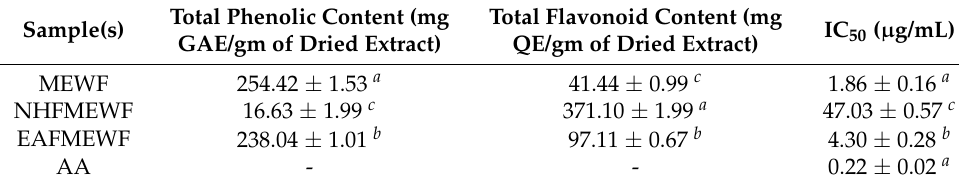
Table 3. Total phenolic contents total flavonoid contents and DPPH free radical scavenging activities of methanol extract of W. fruticosa leaves and its derived fractions. Total Phenolic Content (mg Total Flavonoid Content (mg Sample(s) IC 50 ( µ g/mL) GAE/gm of Dried Extract) QE/gm of Dried Extract) MEWF 254.42 ± 1.53 a 41.44 ± 0.99 c 1.86 ± 0.16 a NHFMEWF 16.63 ± 1.99 c 371.10 ± 1.99 a 47.03 ± 0.57 c EAFMEWF 238.04 ± 1.01 b 97.11 ± 0.67 b 4.30 ± 0.28 b AA - - 0.22 ± 0.02 a Values are expressed as mean ± SEM ( n = 3); values marked with different superscript letters ( a , b , c ) within a column signify statistical differences at p < 0.01 (Tukey’s HSD test); MEWF, methanol extract of W. fruticosa leaves; NHFMEWF, n-hexane fraction of methanol extract of W. fruticosa leaves; EAFMEWF, ethyl acetate fraction of methanol extract of W. fruticosa leaves; AA, ascorbic Acid; GAE, gallic acid equivalent; QE, quercetin equivalent;